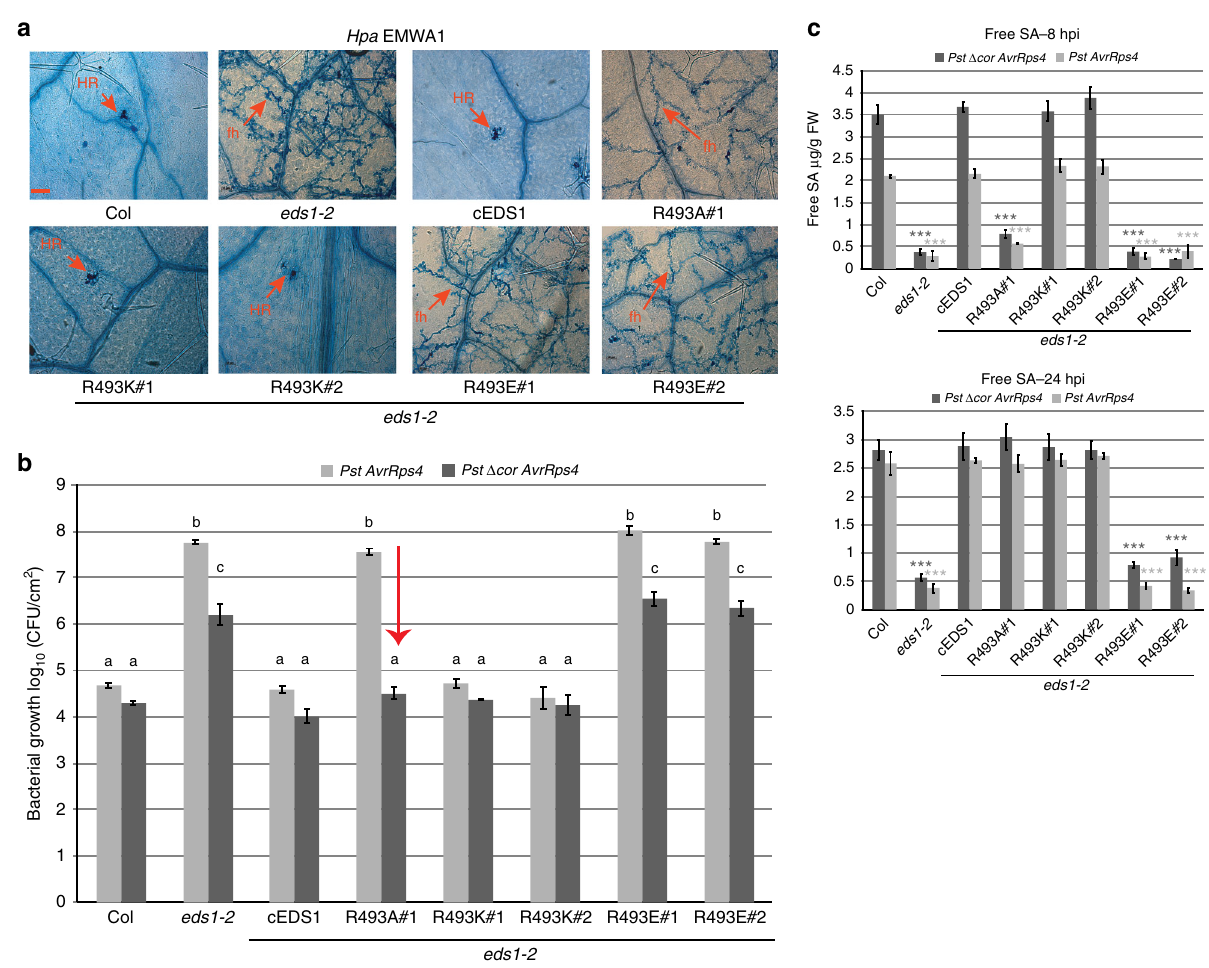
Fig. 5 a positive charge at EDS1 R493 is essential for TNL immunity. RPP4 resistance phenotypes of 2-week-old control and Arabidopsis transgenic lines expressing cEDS1 and R493 mutants, as indicated. Hpa EMWA1 infected leaves were stained with trypan blue at 5 dpi. Scale bar represents 100 μ m. Each image is representative of > 18 leaves from two independent experiments. HR, hypersensitive response; fh, pathogen free hyphae. b Four-week-old Arabidopsis plants of the indicated genotypes were in fi ltrated with Pst AvrRps4 and Pst Δ Cor AvrRps4 (OD – 0.0005). Bacterial titres were determined at 600 3 dpi. Bars represent means of three biological replicates ± SE. Differences between genotypes were analysed using ANOVA (Tukey ’ s HSD, p < 0.05). Similar results were obtained in three independent experiments. c Four-week-old plants were in fi ltrated with Pst AvrRps4 or Pst Δ Cor AvrRps4 and free SA was quanti fi ed at 8 and 24 hpi. Bars represent means ± SE of three biological replicates. Differences between genotypes within treatments were analysed using Student ’ s t -test (Bonferroni corrected, *** p < 0.05) relative to Col. Similar results were obtained in two independent